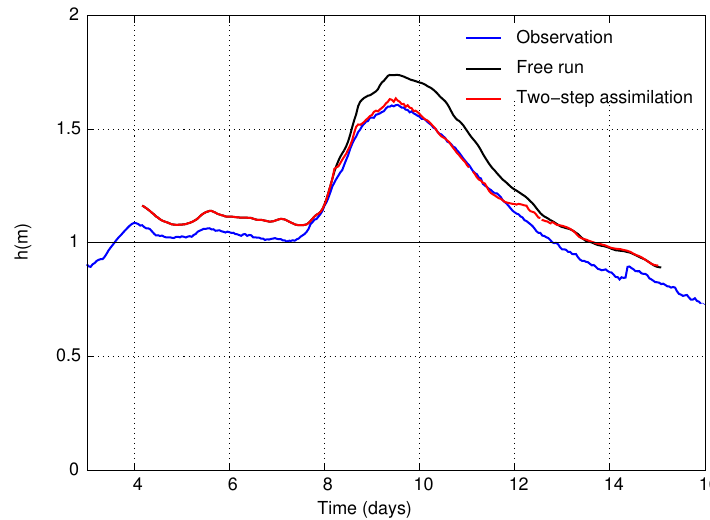
Fig. 11. April 2006 event, Marne Vallage catchment. Two-hour forecasted water level at Joinville for the Free run (black curve), the observation (blue curve) and the analysis of the Assim run with the two-step assimilation (red curve).